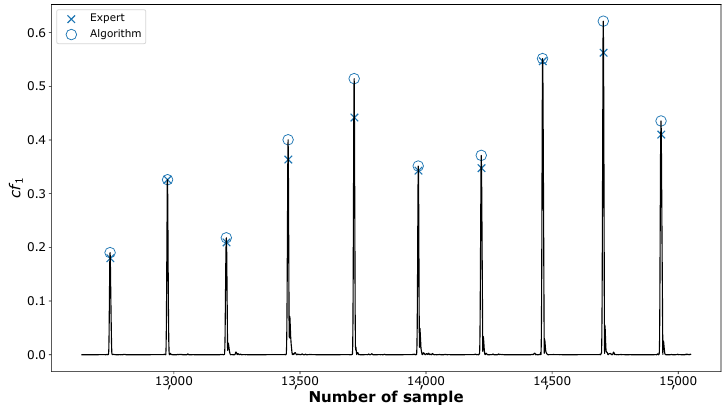
Figure 6. The positions of the C peaks marked in the combination of IMFs cf 1 identified by an expert (crosses “ × ”) and detected by the proposed algorithm (circles “o”).